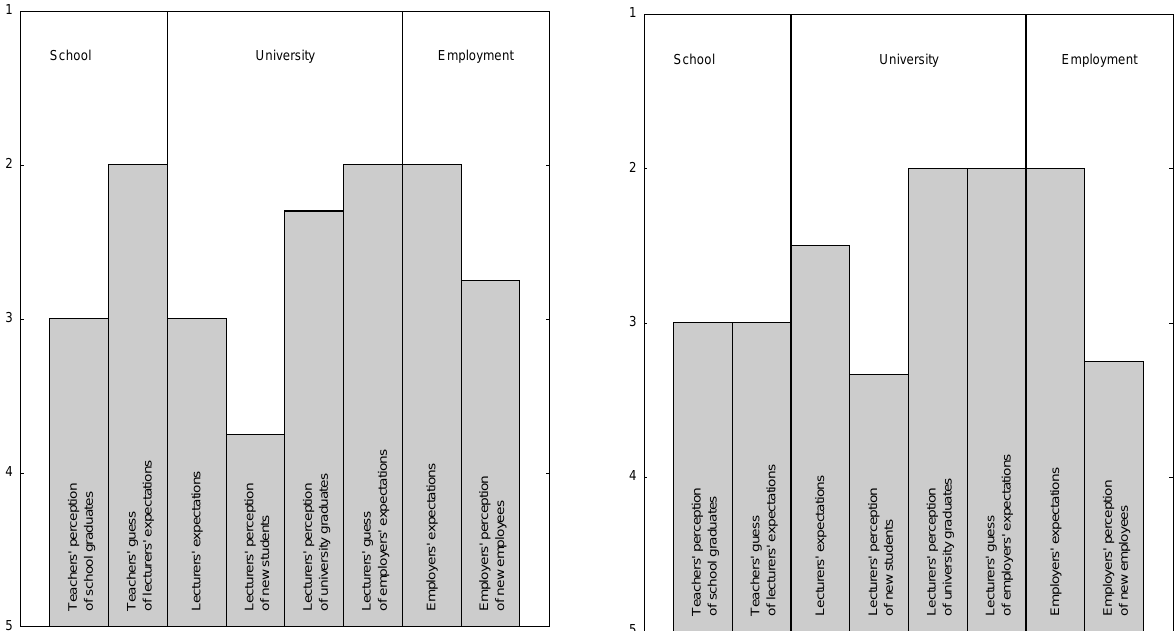
Figure 3. Expectations and perceptions for the competency “Learning and working techniques”.